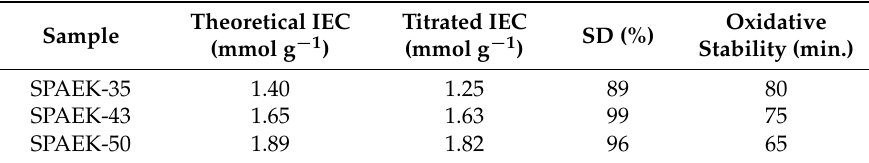
Table 2. IEC, SD and oxidative stability of SPAEKs.